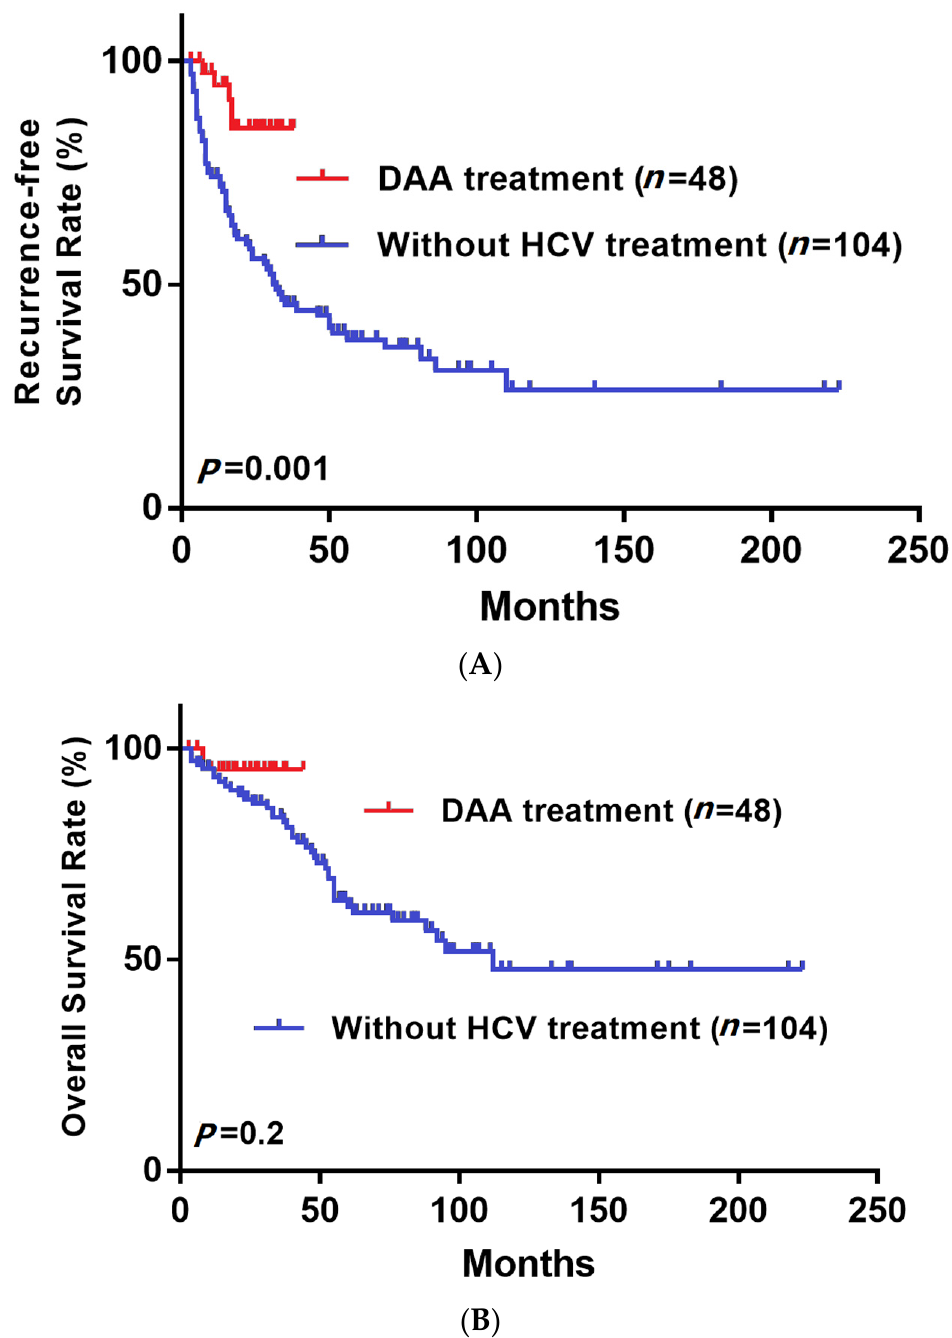
Figure 2. ( A ) Recurrence-free survival (RFS) and ( B ) overall survival (OS) after curative resection for patients with HCC treated with or without DAA.